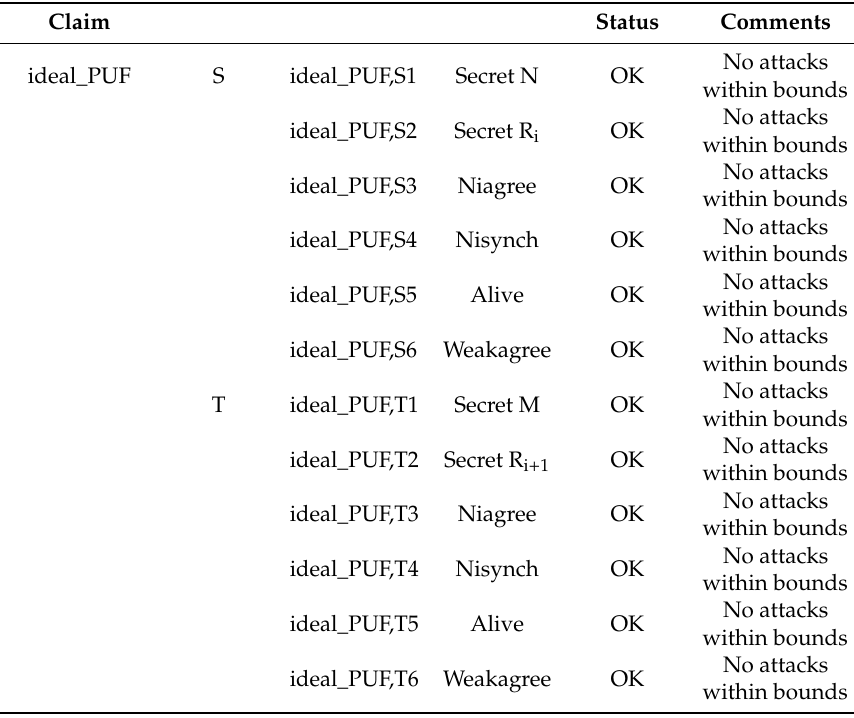
Table 2. The verification outcome of our proposed protocol using Scyther.